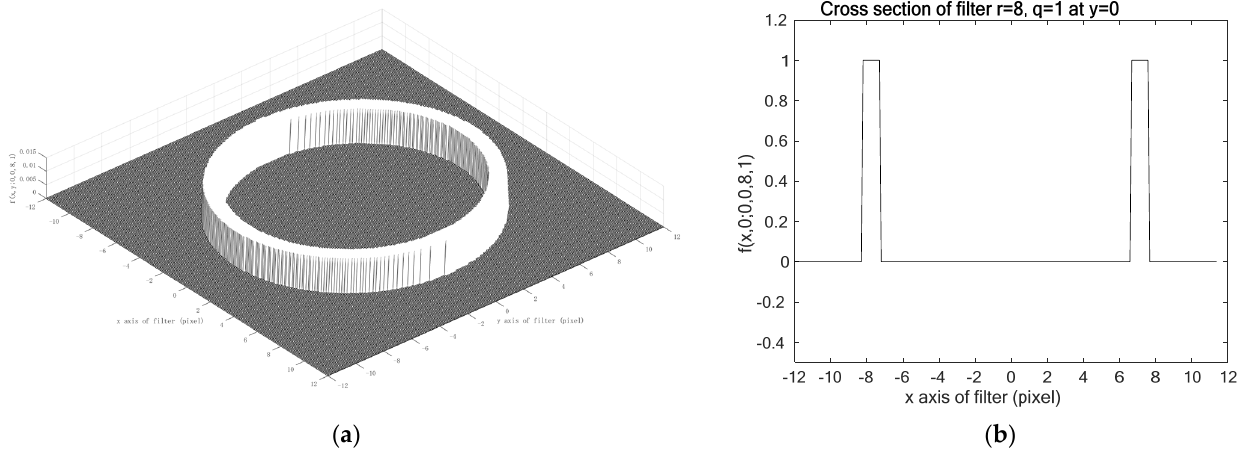
Figure 11. The example of the conventional Hough transform pattern with a uniform-valued ring: ( a ) Bird’s-eye view; and ( b ) cross-section at y = 0.